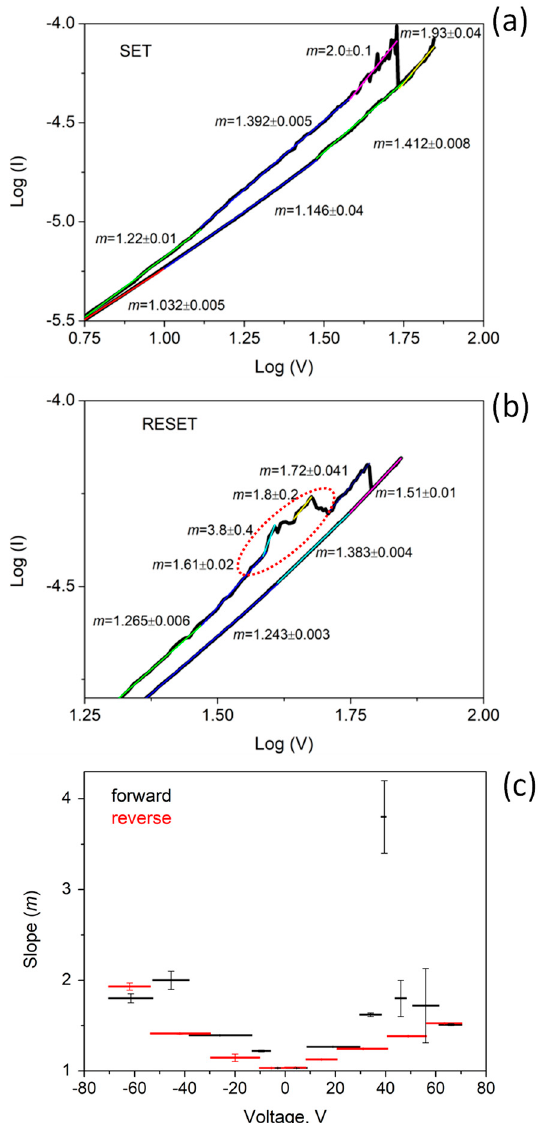
Figure 8. Log-log plot of the pinched hysteresis curve: ( a ) SET, ( b ) RESET, ( c ) slope in the piecewise approximation versus the bias voltage V.